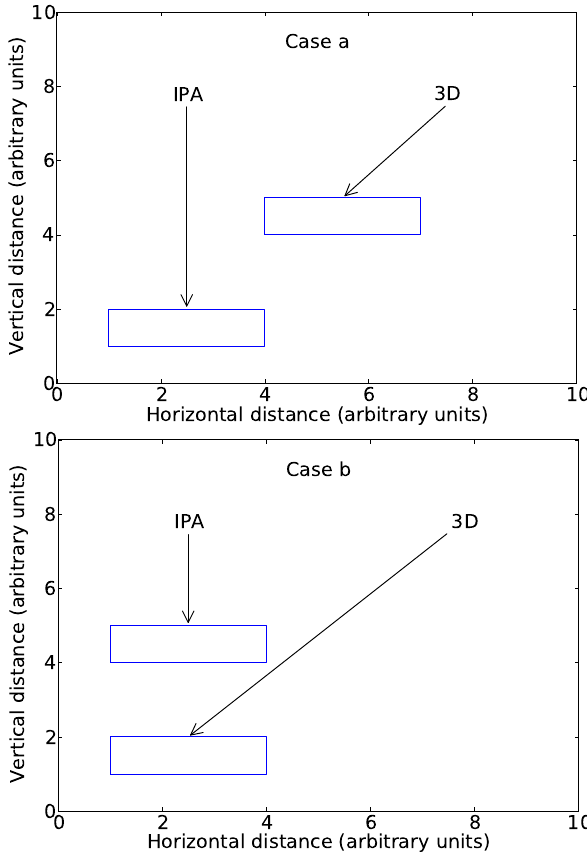
Fig. 11. Clouds “seen” by the IPA approximation and the 3-D sim- ulations for the two different cases described in the text. Arrows indicate the clouds